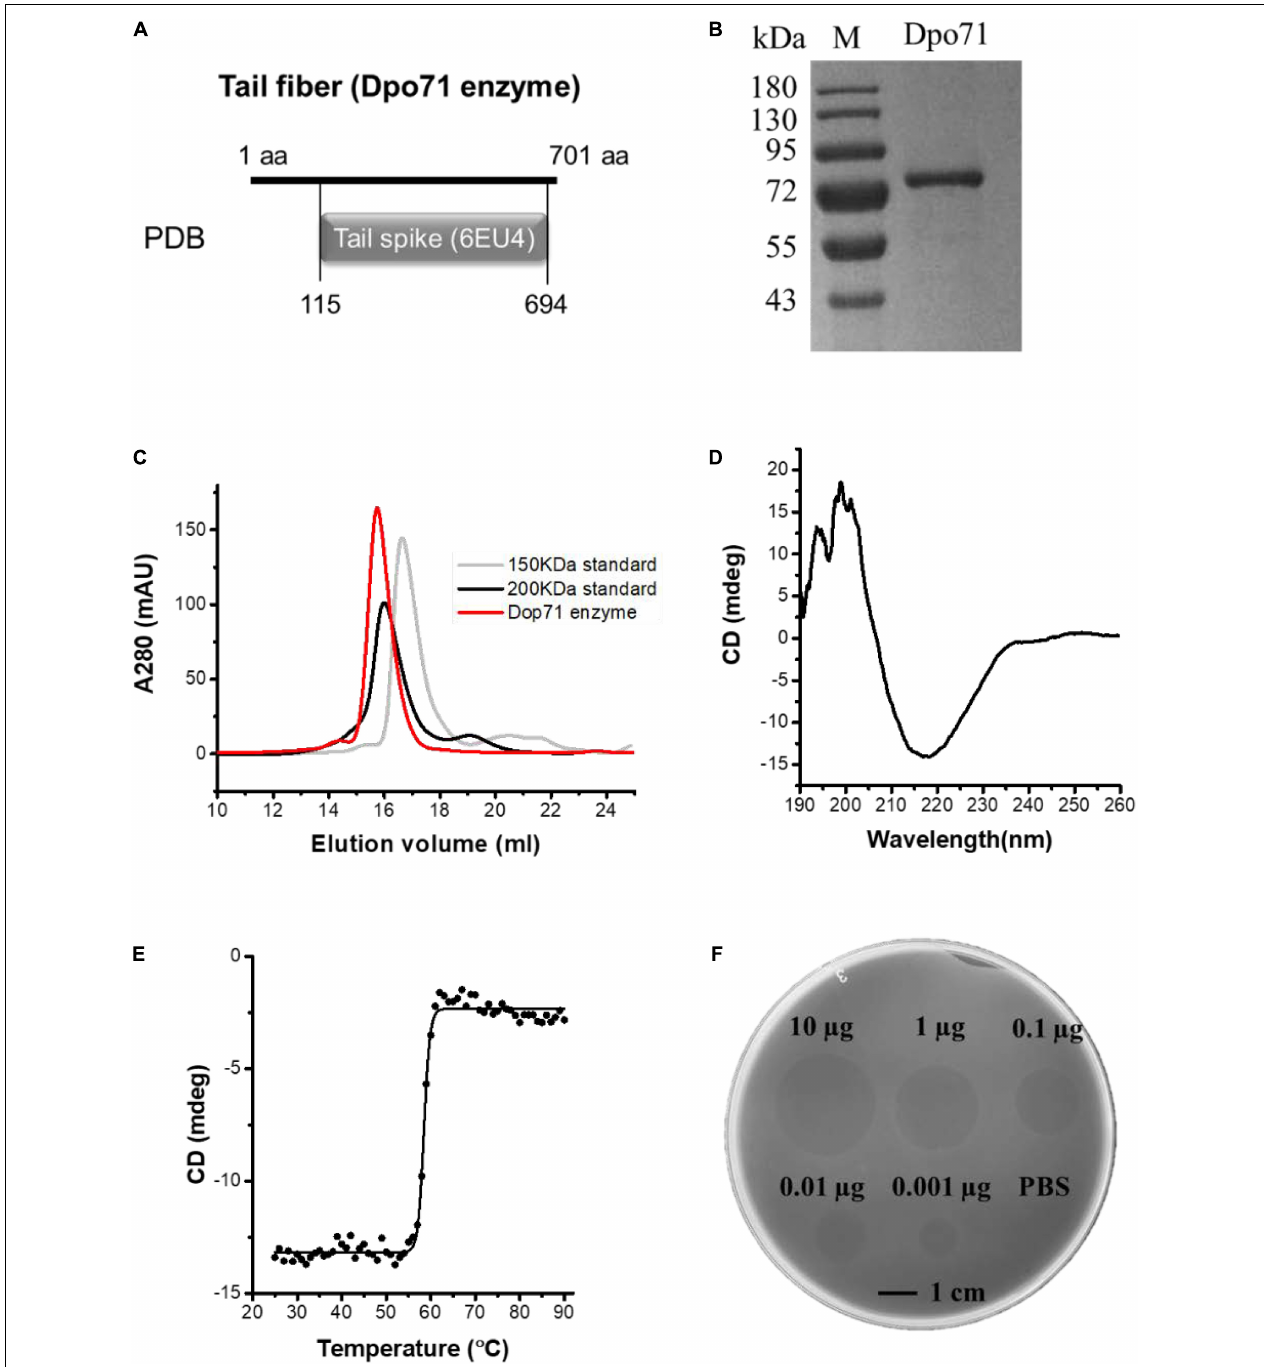
FIGURE 1 | Identification and characterization of Dpo71 depolymerase. (A) Bioinformatic analysis indicates the gp71 gene of the IME-AB2 phage. (B) SDS gel electrophoresis analysis of purified Dpo71 and a standard molecular mass marker (Lane M). (C) Size exclusion chromatography of purified depolymerase protein. (D) Circular dichroism analysis of Dpo71 measured in the far-UV (190–260 nm). (E) The melting curve of Dpo71 acquired at 215 nm from 20 to 90 ◦ C. (F) Spot test assay of Dpo71 against A. baumannii lawn (0.001–10 µ g).